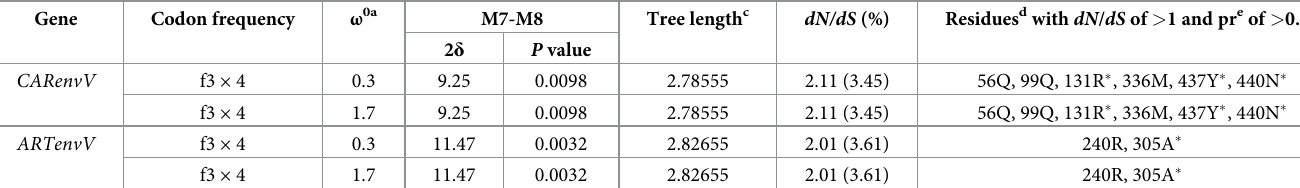
Table 1. PAML analysis of CARenvV and ARTenvV . Gene Codon